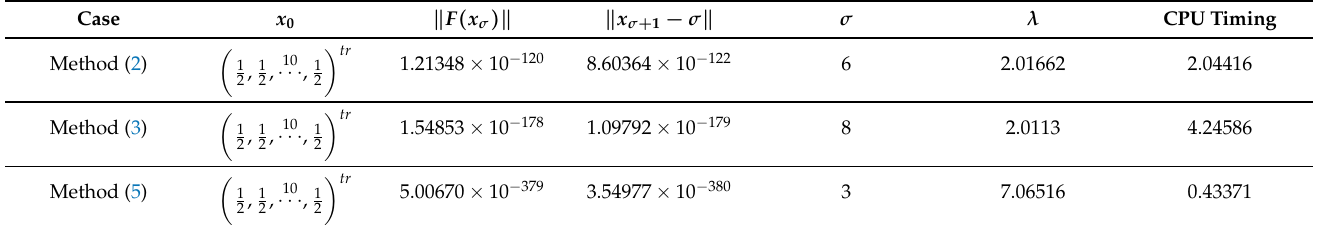
Table 4. Numerical results of Example